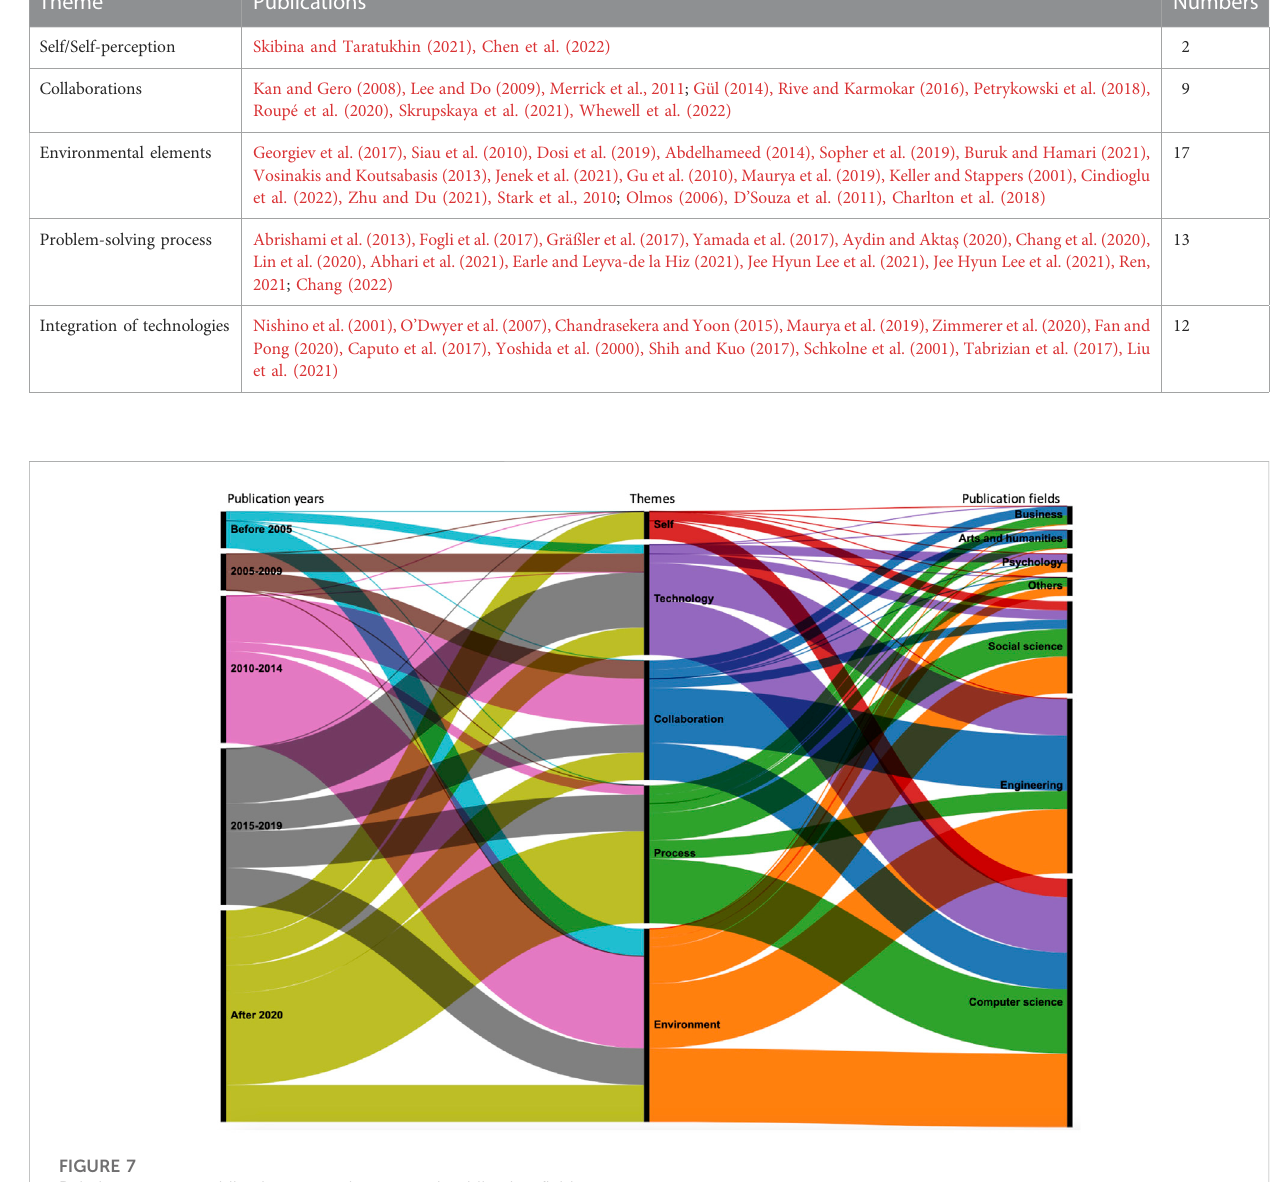
FIGURE 7 Relations among publication years, themes, and publication fi